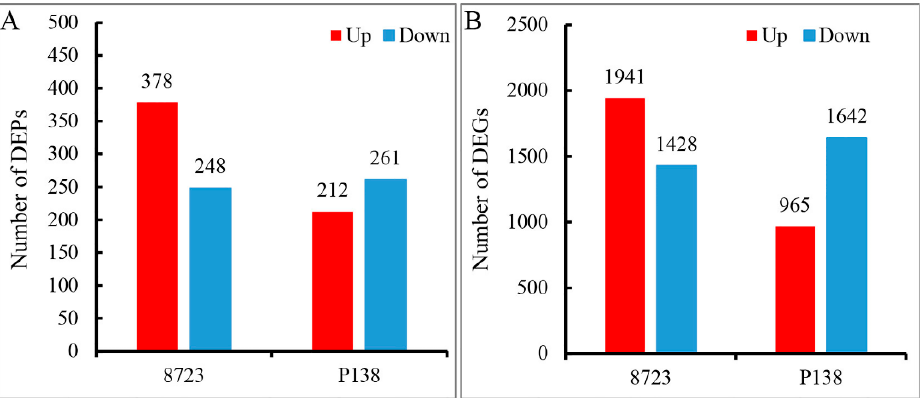
Figure 1. Comparison of DEPs and DEGs in lines 8723 and P138 in response to salt stress. ( A ) The numbers of DEPs in each line; ( B ) the numbers of DEGs in each line.